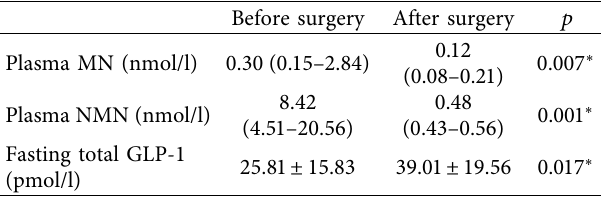
Table 3: Plasma MNs and GLP-1 levels of study patients before and after surgery ( n � 13). Before surgery After